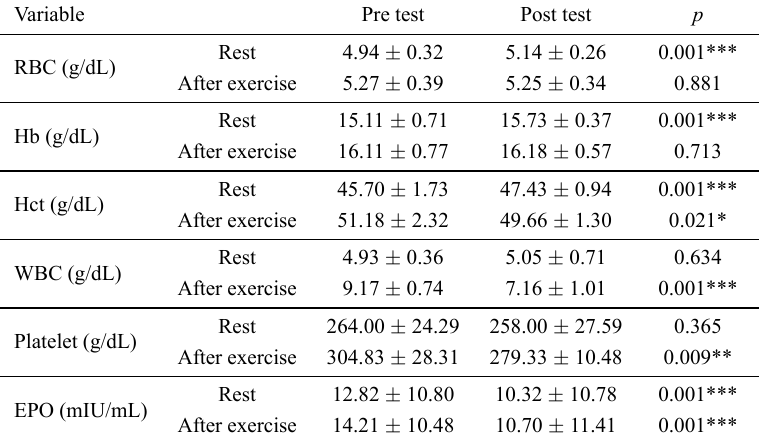
Table 5. Change in CBC and erythropoietin. (Mean Values ±